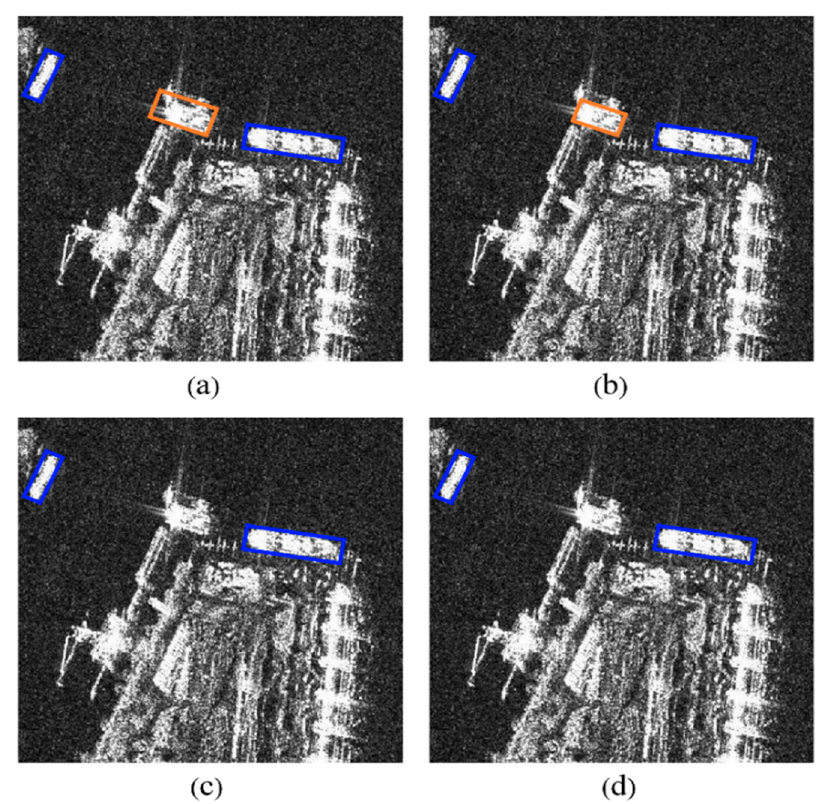
Figure 20. The effect of FEM. ( a ) The detection result of the experiment setting of NO CBAM and NO FEM. ( b ) The detection result of the experiment setting of YES CBAM and NO FEM. ( c ) The detection result of the experiment setting of NO CBAM and YES FEM. ( d ) The detection result of the experiment setting of YES CBAM and YES FEM. The blue rectangles indicate detected ships. The orange rectangles indicate the false alarms.